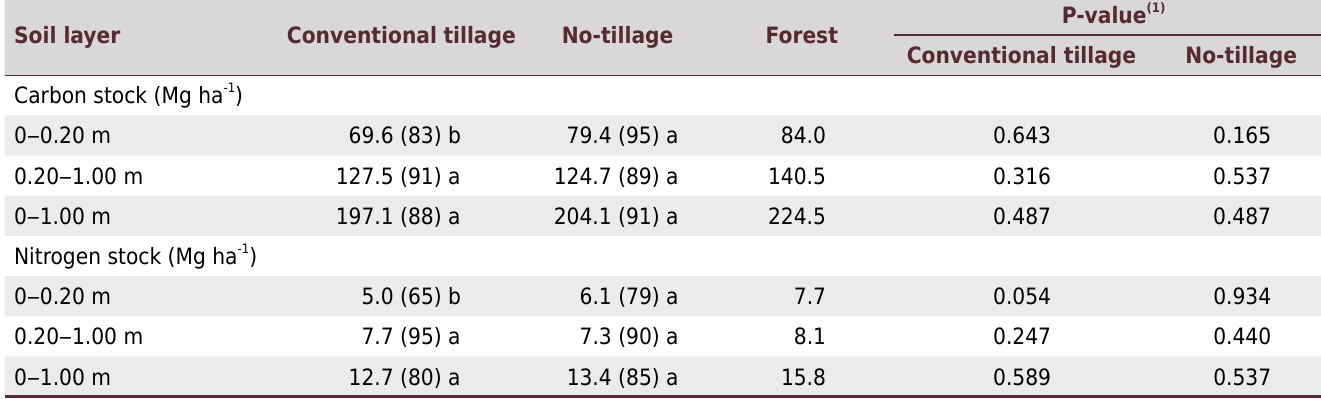
Table 4. Soil C and N stocks affected by soil tillage system after 26 years and comparison with the adjacent native forest Soil